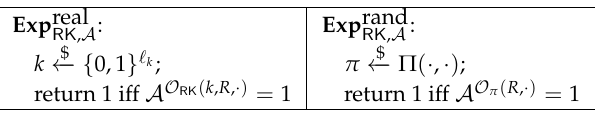
Figure 7. Experiments for the re-keying